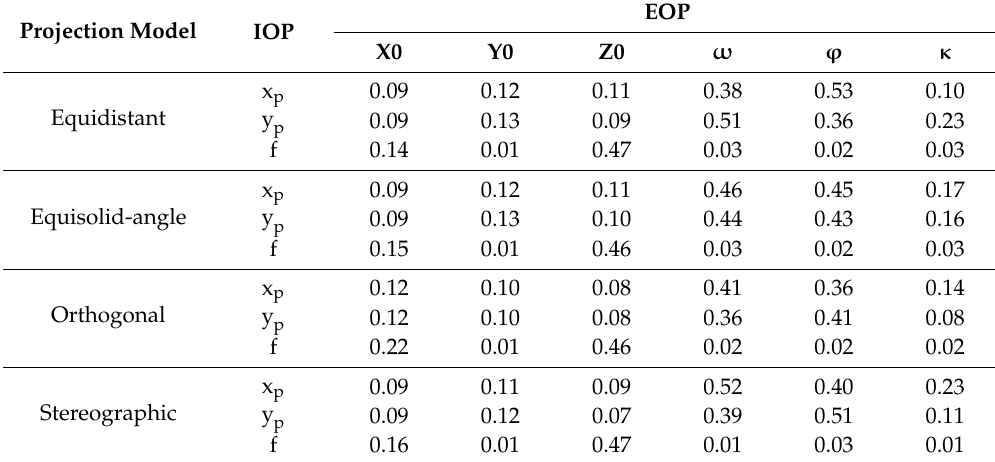
Table 18. Correlation between the orientation parameters (image-set 2).